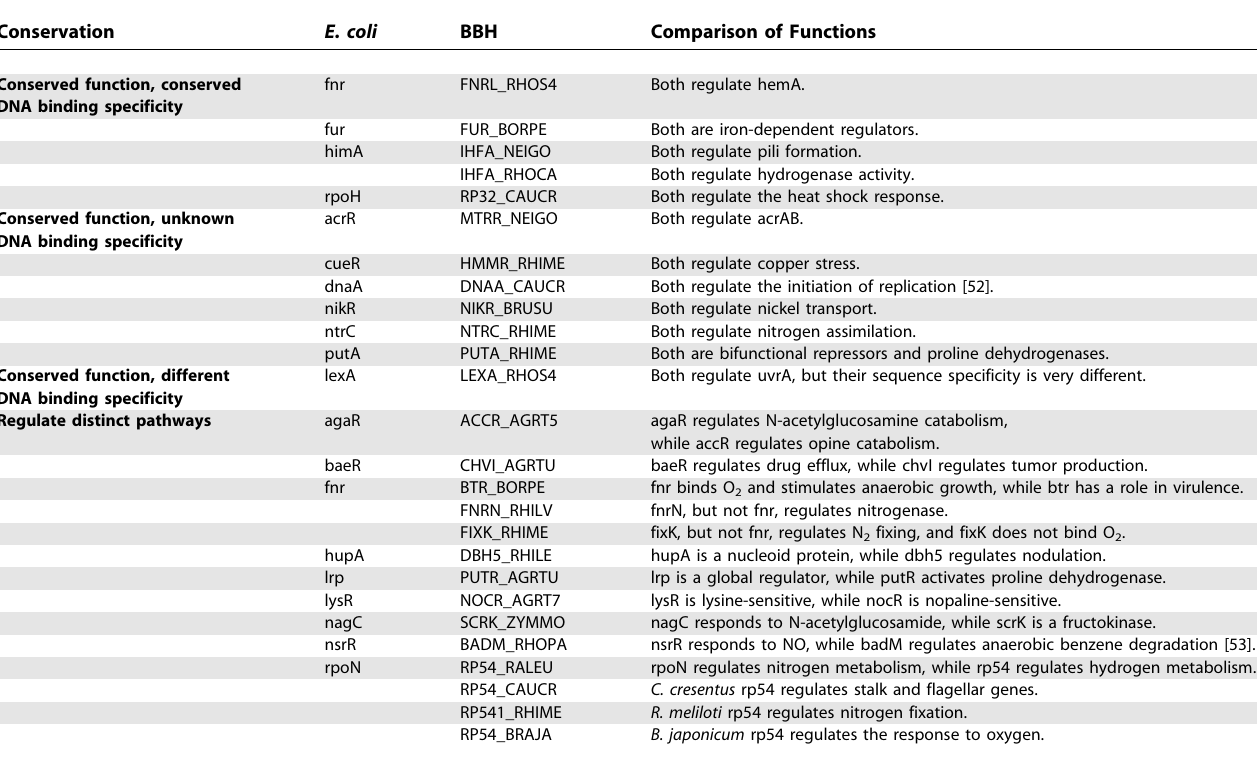
Table 3. Characterized ‘‘ Orthologs ’’ of Transcription Factors between E. coli K12 and a , b -Proteobacteria Conservation E. coli